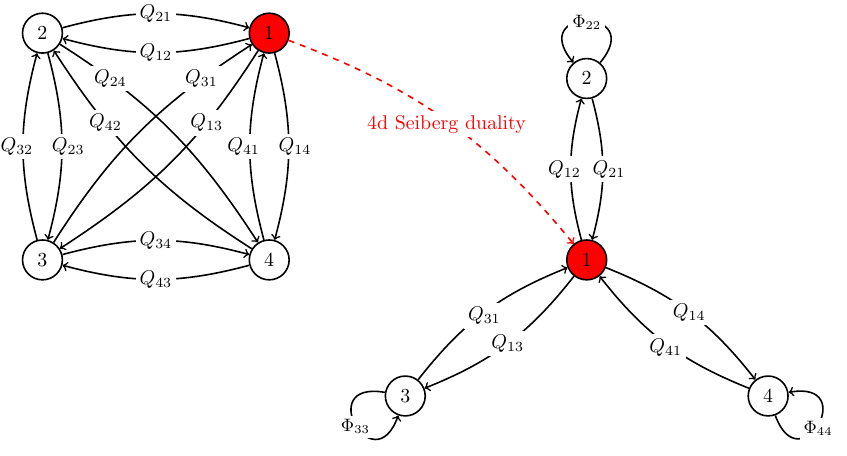
Figure 4 . Seiberg duality for the toric Z represented by the non-toric quiver with three